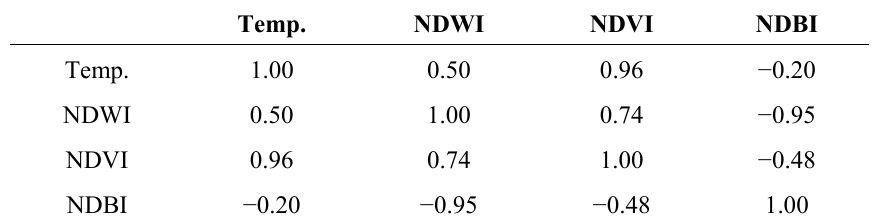
Table 2. Correlation matrix of the mean values from the indices and LST in a water cover pattern.